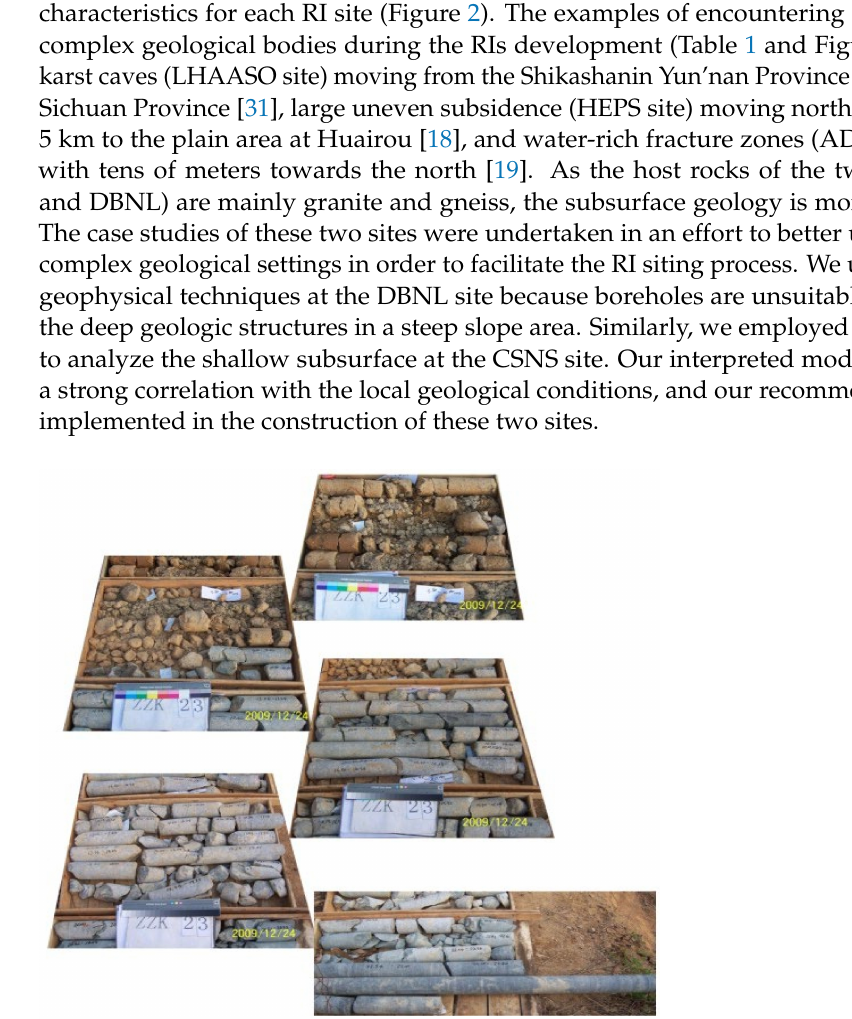
Figure 2. Drilled cores from borehole ZZK23 used to locate the ring accelerator at the CSNS